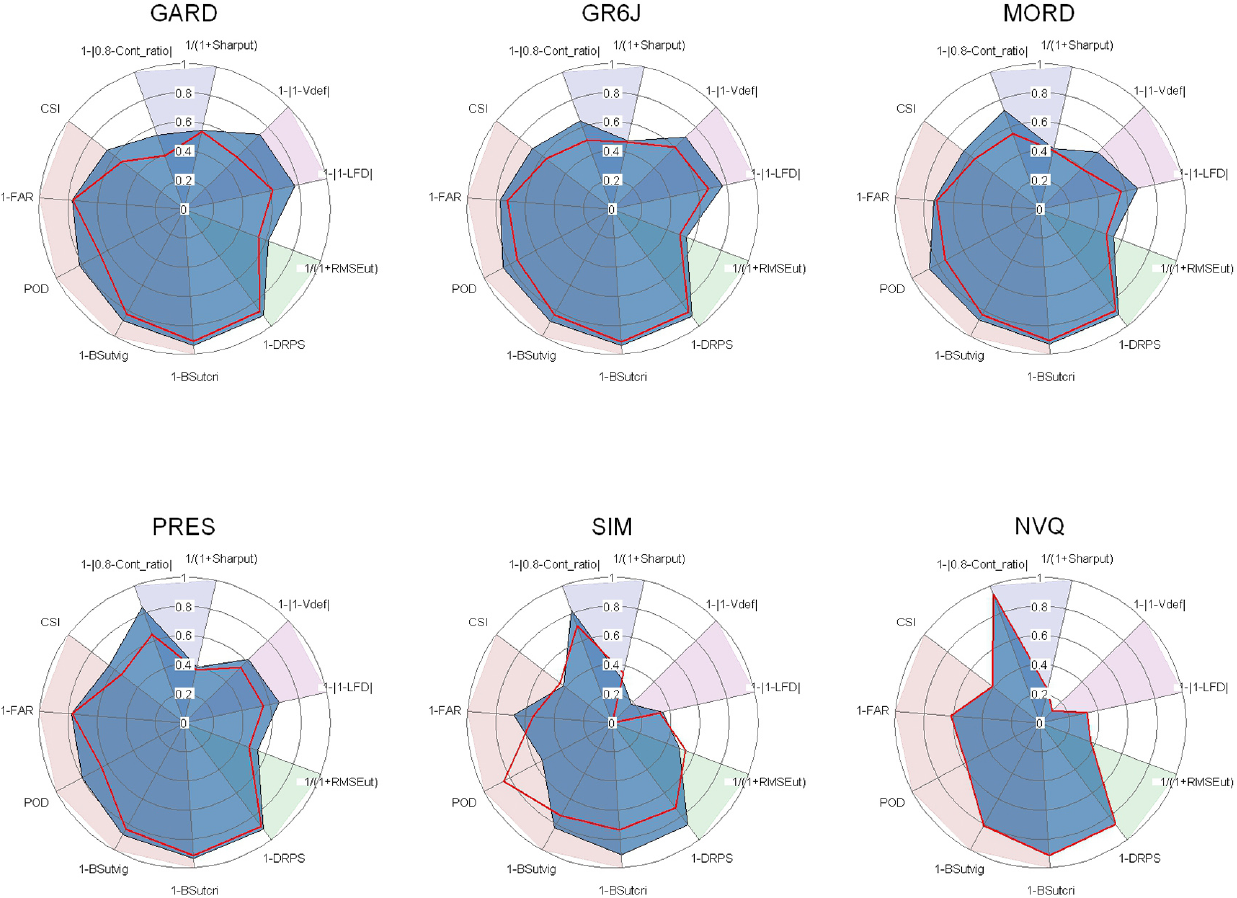
Figure 8. Radial plot of the mean model results for the 21 catchments for the selected criteria in validation period 2, for a D + 7 forecasting lead time. Red lines represent the results when no assimilation or post correction method is